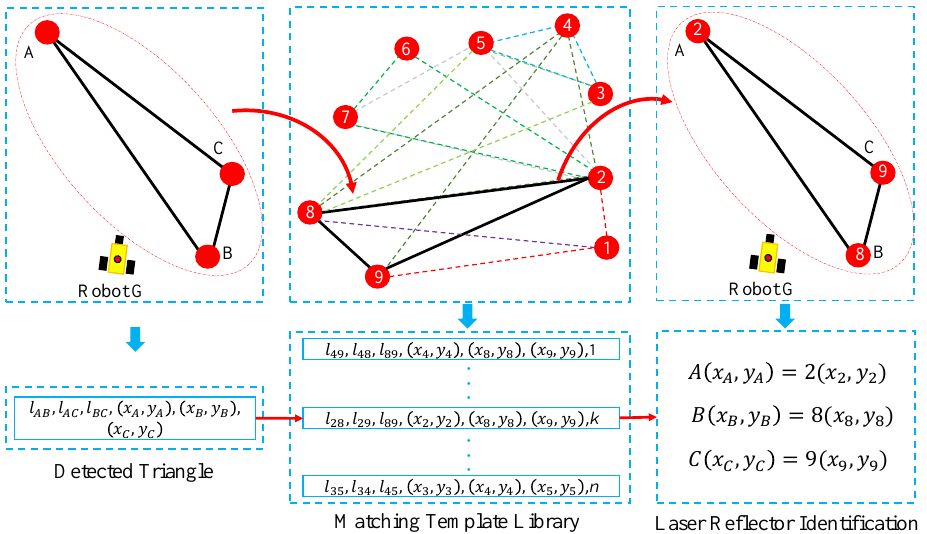
Figure 2. The process of triangle matching. A, B, C are the detected laser reflectors and ( x i , y i ) is the coordinate of the i -th detected laser reflector. l ij is the distance between the reflector i and j . G is the mobile robot. The number is the ID of the laser-reflector landmarks in matching template library M